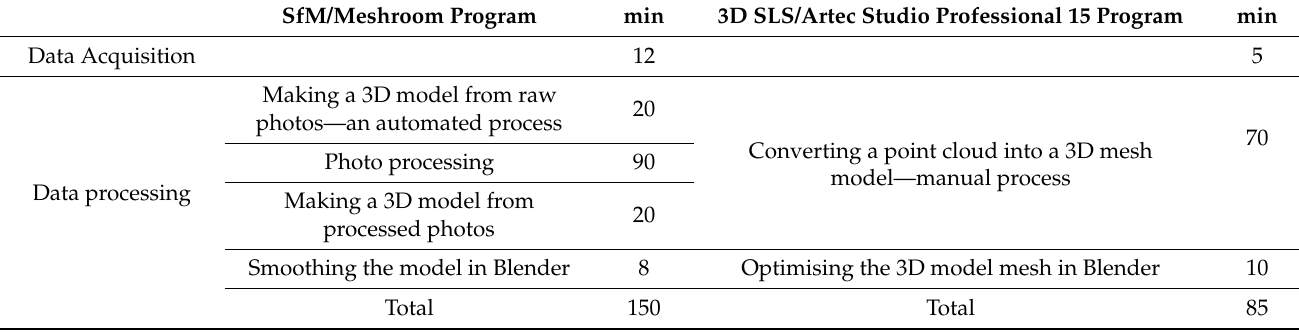
Table 6. Time-consuming production of the 3D model of the jug using the SfM and 3D SLS methods.